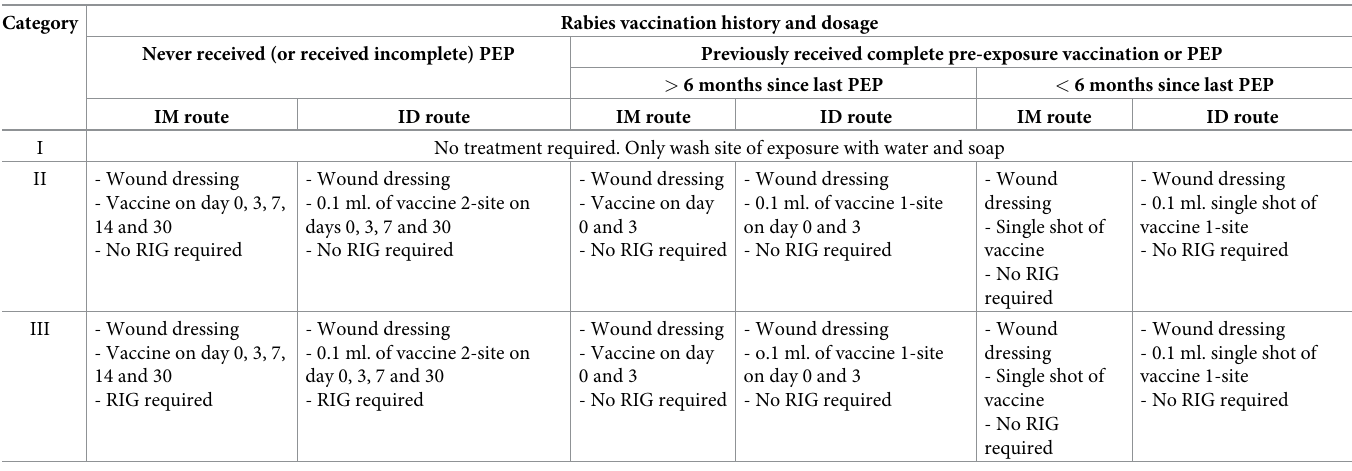
Table 1. Thailand rabies post exposure prophylaxis guideline